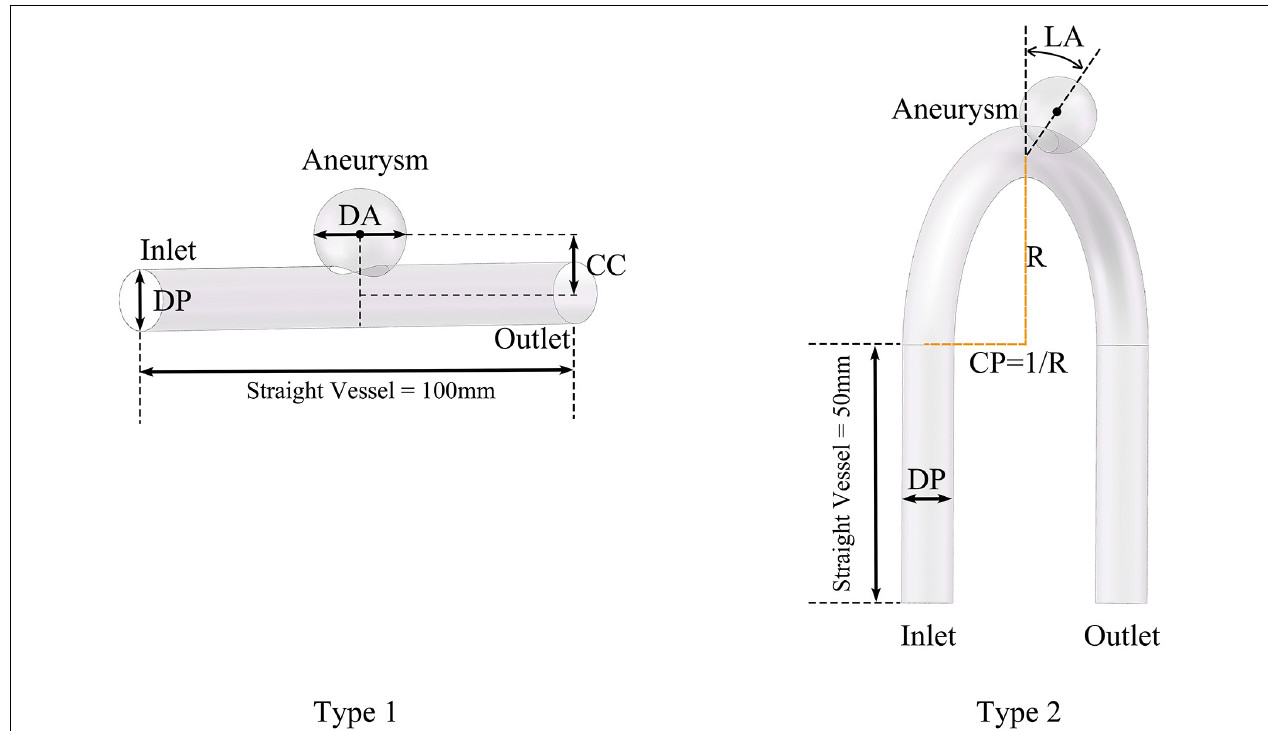
FIGURE 1 | Definition of morphological parameters and generation of cerebral aneurysm models.